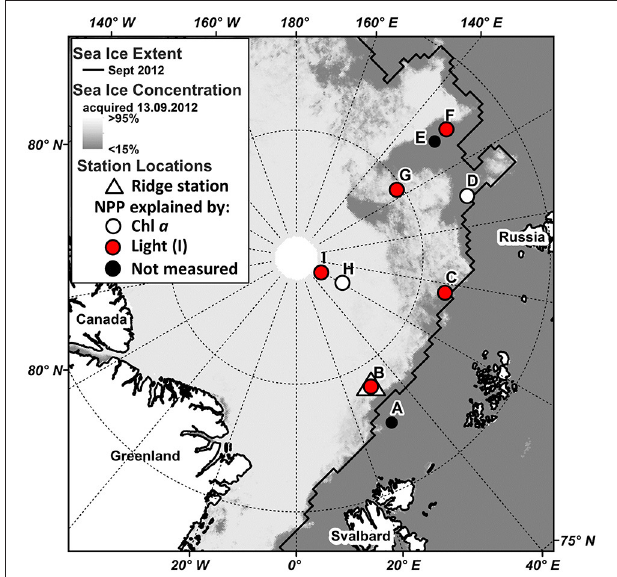
FIGURE 1 | Map of the Arctic Ocean with sea ice extent and concentration data, and the locations of the corresponding station groupings conducted during the 2012 PS80 cruise (station numbers for each grouping are listed in Table 1 ). Locations are color coded to identify which variable, light (red) or chl a biomass (white), explains the dominant portion of the net primary production variance. The ice station with identified ridges, station 224 (location B), is identified by a triangle. Sea ice concentration data acquired from www. meereisportal.de according to algorithms in Spreen et al. (2008). Sea ice extent correspond to the 2012 September monthly mean (extent data acquired from NSIDC, (Fetterer et al., 2002, updated 2011).